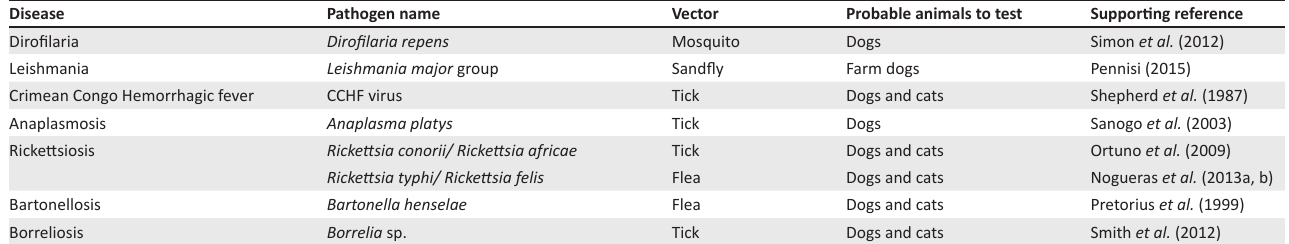
TABLE 2: Vector-borne diseases of public and veterinary health importance reported in Namibia for which surveillance could be enhanced using sentinel studies in companion dogs and cats.